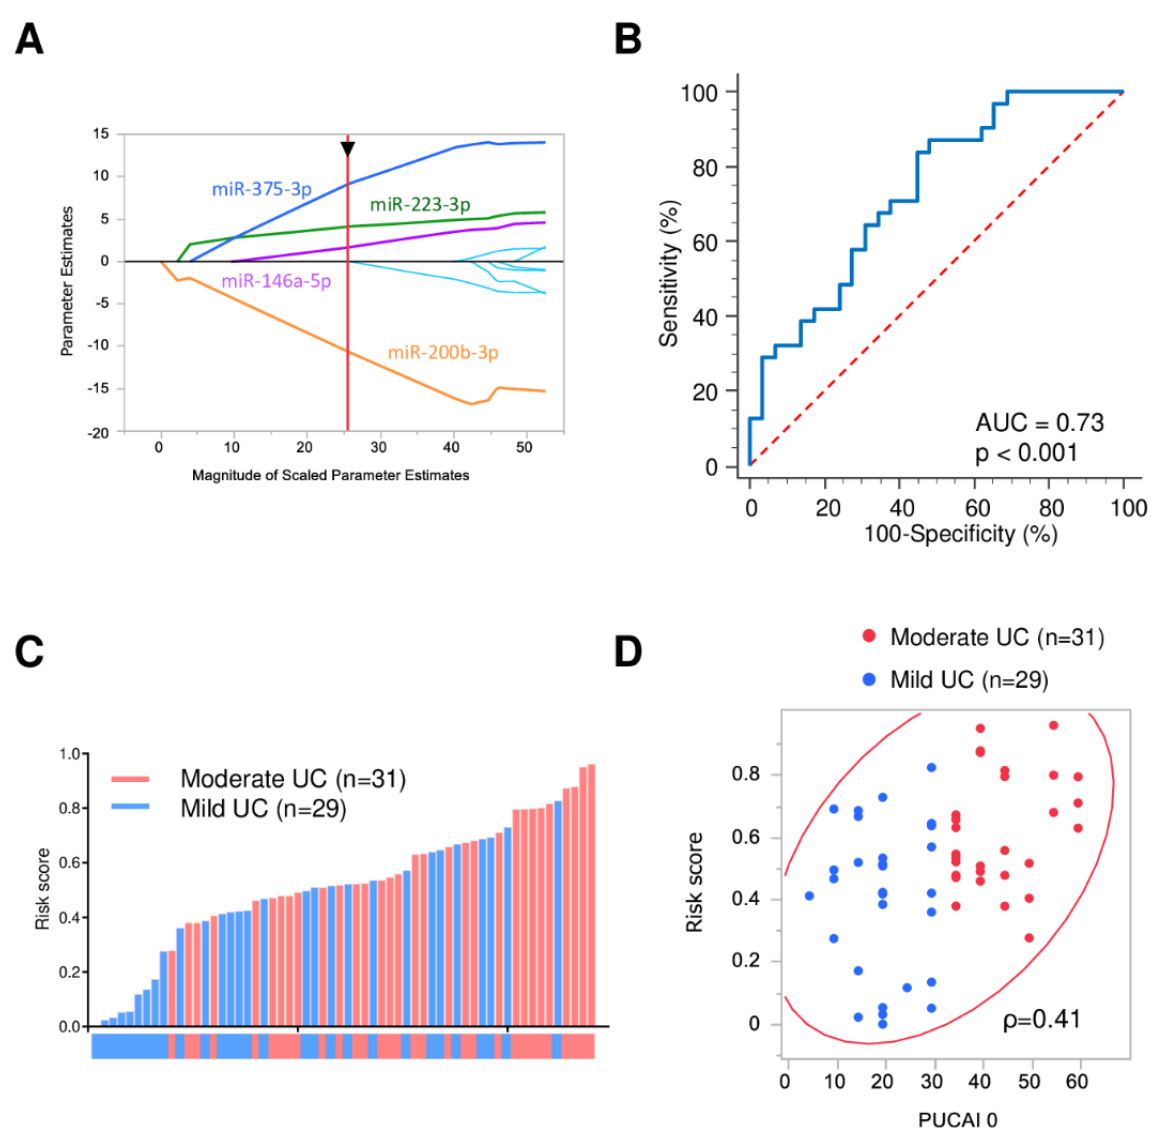
Figure 3. Diagnostic accuracy of 4-miRNA panel for identifying severity of UC patients. ( A ) Adaptive LASSO model; ( B ) ROC curves for detecting UC patients using 4-miRNA panel; ( C ) A waterfall plot representing risk score of each patient. Red and blue columns indicate moderate and mild UC patients, respectively; ( D ) A scatter plot showing the correlation of PUCAI with risk score. Red and blue circles indicate moderate and mild UC patients, respectively. ρ is the Spearman’s rank correlation coefficient.